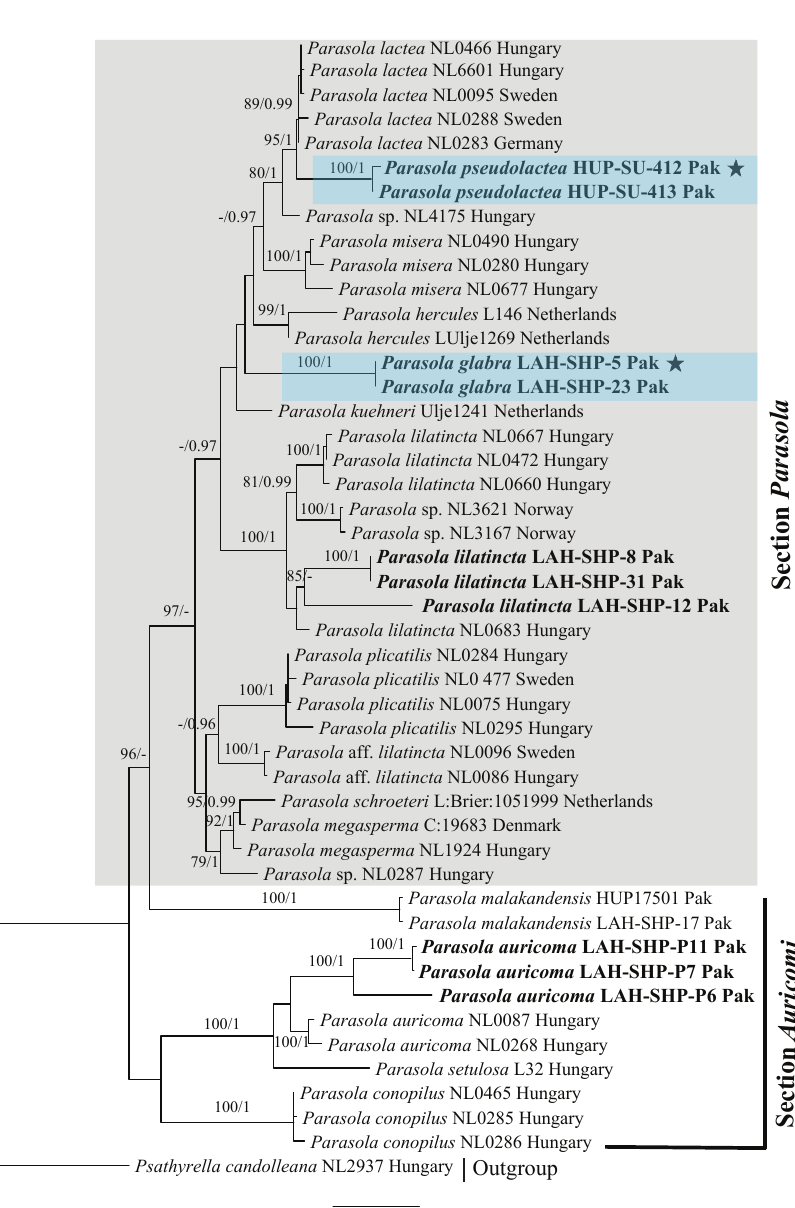
Figure 2. Phylogeny of Parasola species based on 47 sequences of combined ITS-28S dataset. Our se- quences are indicated in boldface. Other sequences are from Nagy et al. (2009). Numbers above or below branches indicate maximum likelihood bootstrap percentages followed by Bayesian posterior probabili- ties. Species in section Parasola are gray highlighted where the new species are shown as light-blue, while the HOLOTYPE collection for P. glabra (LAH-SHP-5) and P. pseudolactea (HUP-SU-412) are repre- sented by stars